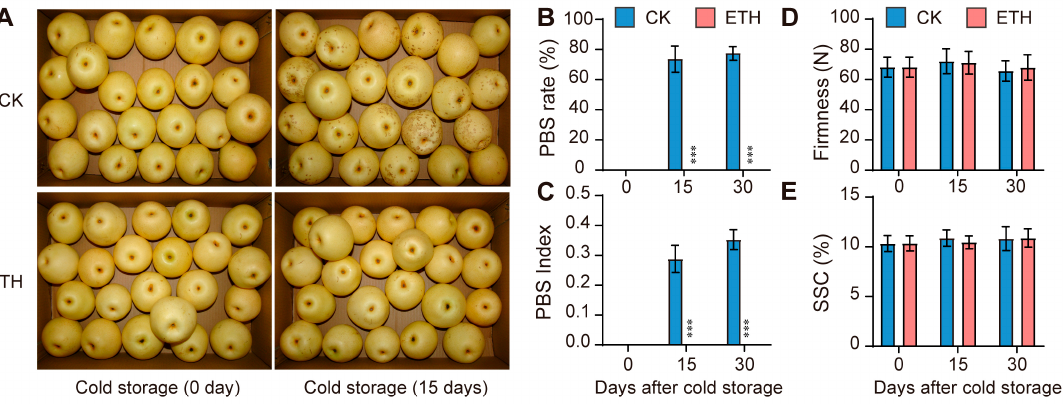
Figure 1. Ethylene pretreatment inhibits peel browning spots (PBS) occurrence. ( A ) Control (CK) and ethylene-pretreated (ETH, 100 μ L/L) fruit after 15 days of cold storage (0 °C). ( B ) and ( C ) PBS rate and PBS index were calculated during cold storage. ( D ) and ( E ) Assessment of fruit firmness and soluble solids content (SSC) during cold storage. All data are mean ± standard deviation from three biological replicates. Asterisks indicate significant differences (*** p < 0.001) as calculated using two-tailed Student’s t -test within each time point.